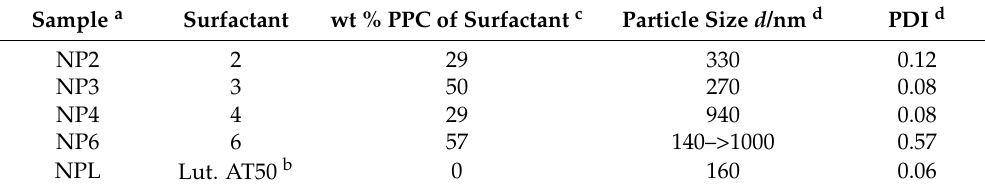
Figure 6. ( left ): SEM image of the synthesized PS nanoparticles (NP3). Scale bar = 1 µm. ( middle ): picture of a stable aqueous PS nanoparticle emulsion with mPEG 113 - b -PPC 49 (Table 1, sample 3) as a surfactant and an instable emulsion after 36 h in conc. HCl. ( right ): FT-IR spectra of PS particles before (black) and after (red) degradation of the surfactant mPEG 113 - b -PPC 49 (Table 1, sample 3). Table 2. Overview of all synthesized PS nanoparticles and the surfactants applied for miniemulsion polymerization.